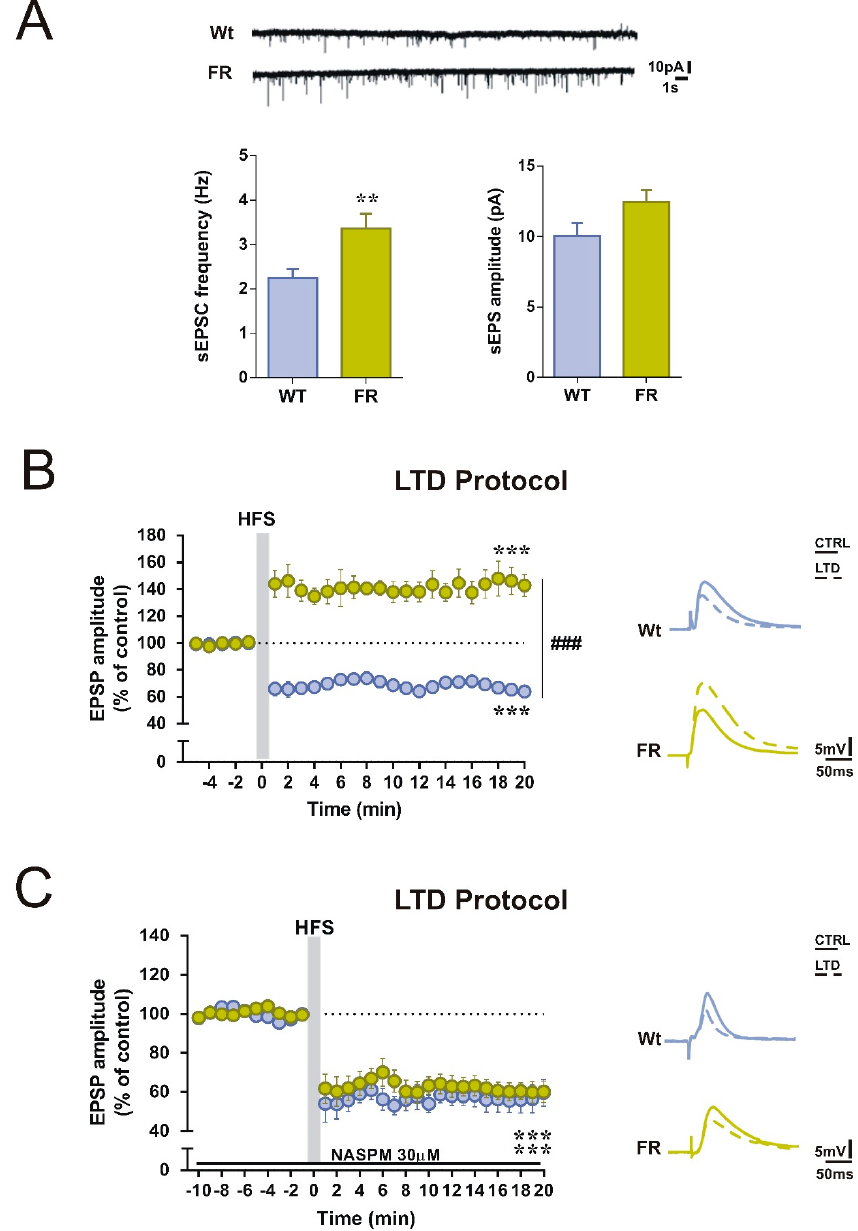
Figure 2. Enhanced activity of GluA2-lacking AMPARs in food-restricted (FR) mice is associated with changes in the direction of corticostriatal synaptic plasticity in SPNs. ( A ) Frequency and amplitude of sEPSCs glutamatergic transmission in Naïve and FR mice. In the upper part, comparison traces of spontaneous activity recorded from groups are shown. The frequency of sEPSC is increased in FR mice compared to Naïve mice (unpaired t-test, Naïve n = 10, vs . FR n = 8, t = 3.088, df = 19, ** p < 0.01). ( B ) Left panel: time course of excitatory postsynaptic potential (EPSP) amplitude of SPNs from Naïve and FR mice after induction of long ‐ term depression (LTD) protocol (high ‐ frequency stimulation, HFS) (paired t-test pre vs . 20 min post ‐ HFS, Naïve n = 7, t = 12.10, df = 12, *** p < 0.001, FR n = 9, t = 7.299, df = 17, *** p < 0.001). Grouped analysis shows significant group effect (two-way ANOVA: time x group interaction F (24,336) = 18.85, Bonferroni’s post hoc ### p < 0.001). The scale factor is 50 ms/5 mV for all traces. Right panel, representative traces of single SPNs recorded from Naïve and FR mice before (solid lines) and after HFS (dotted lines). ( C ) Left panel: time course of SPNs EPSP amplitude, recorded from Naïve and FR mice in the presence of 30 µ M 1-naphthylacetyl spermine (NASPM) bath application for the whole duration of the experiment (paired t-test pre vs . 20 min post-HFS, Naïve n = 8, t = 8.017, df = 15; FR n = 9, t = 10.55, df = 17, *** p < 0.001 for both groups). The scale factor is 50 ms/5 mV for all traces. Right panel, representative traces of single SPNs recorded from Naïve and FR mice before (solid lines) and after HFS (dotted